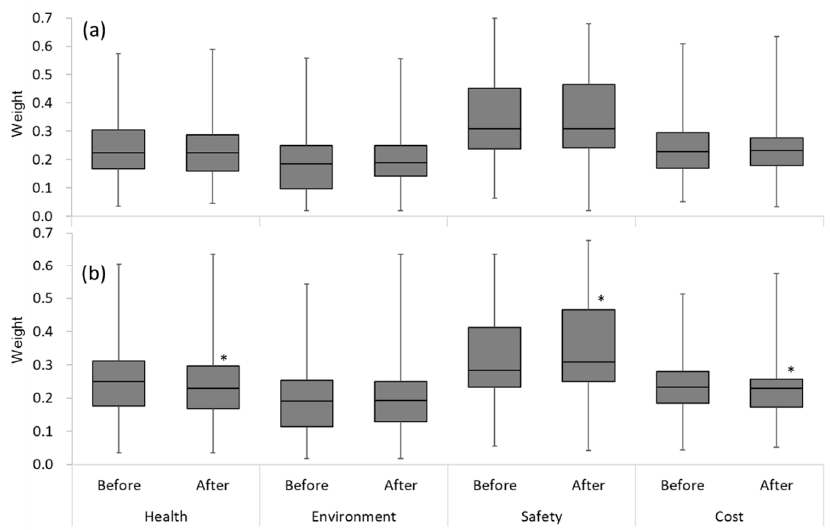
Figure 5. Weights of evaluation criteria by age group: ( a ) 18–29 years; ( b ) 30–39 years (left: before watching video; right: after watching video). Two-sided test, alternative hypothesis: “before watching video” ≠ “after watching video”, * p < 0.05. In the box plots, the boundary of the box closest to zero indicates the 25th percentile, the black line within the box marks the median, and the boundary of the box farthest from zero indicates the 75th percentile. Whiskers above and below the box indicate the 95th and 5th percentiles, respectively.